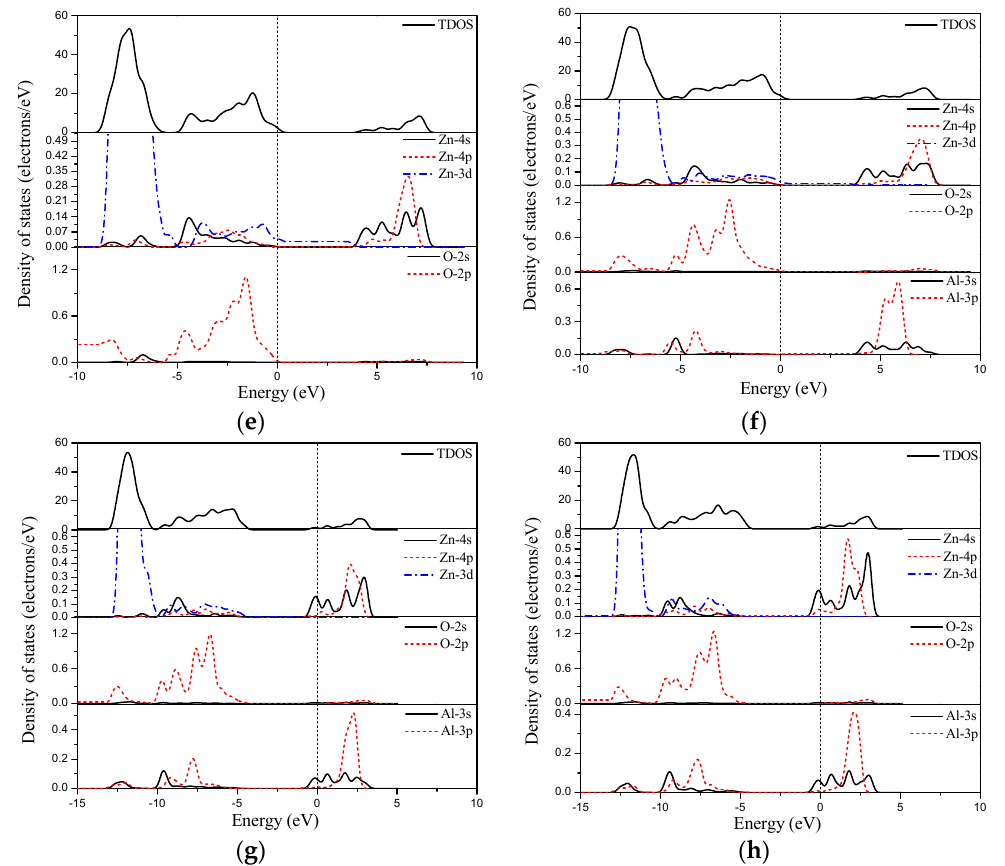
Figure 5. The total and partial total density of states (DOS) of ( a ) pristine bulk ZnO; ( b ) 6.25 at%; ( c ) 12.5 at%; ( d ) 18.75 at% Al-doped bulk ZnO; ( e ) pristine ZnO monolayer; ( f ) 6.25 at%; ( g ) 12.5 at%; ( h ) 18.75 at% Al-doped ZnO monolayer.